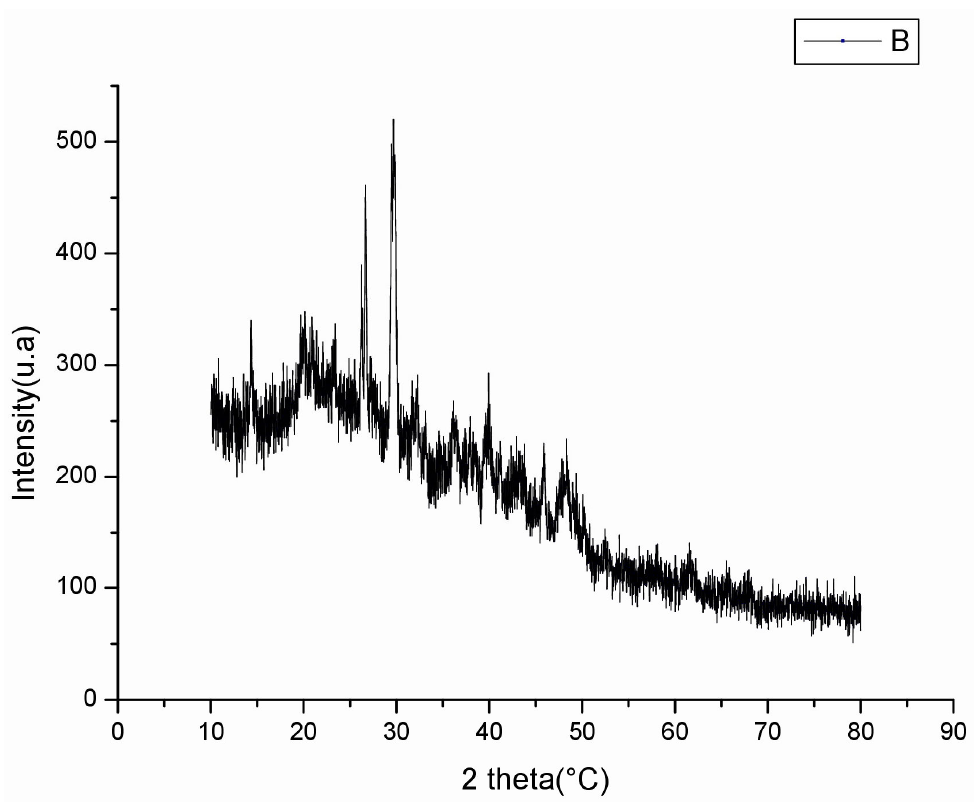
Figure 3. X-Ray Diffraction of Figure 3. X ‐ Ray Diffraction of PSGS.